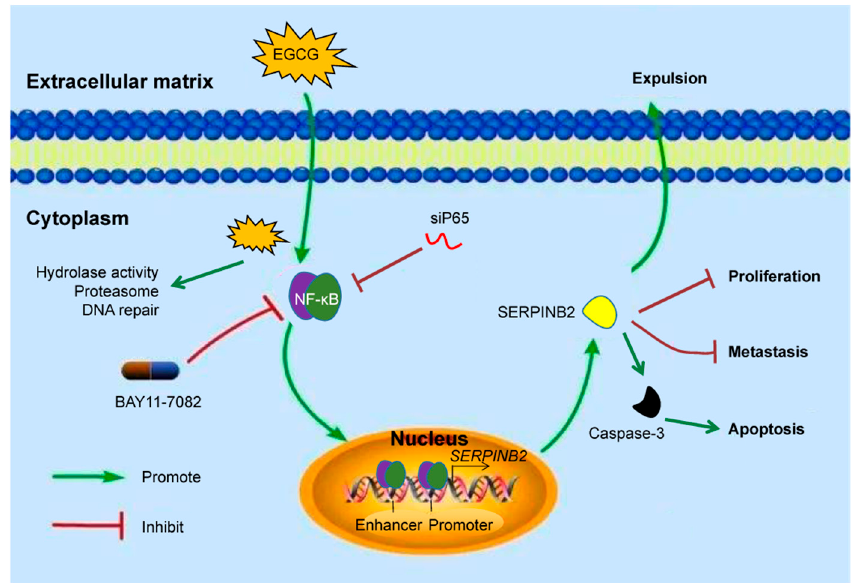
Figure 7. Diagrammatic sketch showing the regulations of EGCG on SERPINB2 expression and related pathways.